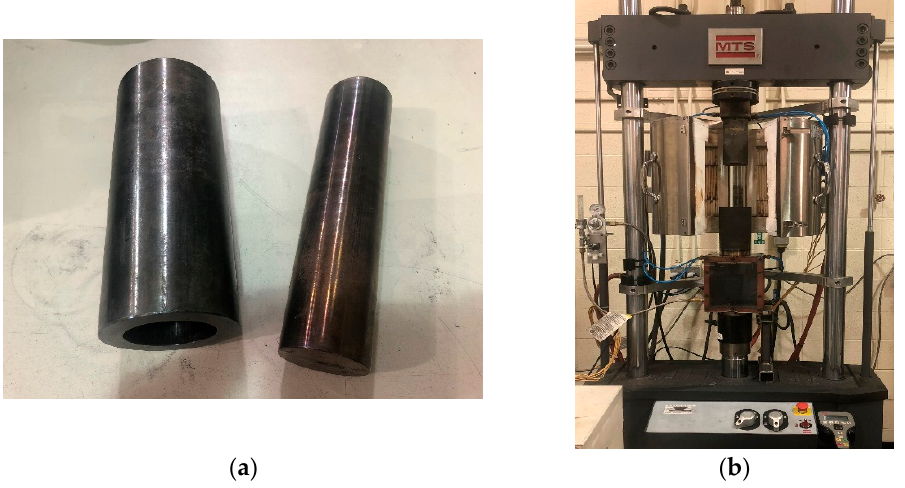
Figure 1. Device for the compaction of green anode samples by MTS servohydraulic press: ( a ) rigid die; ( b ) MTS servohydraulic press.